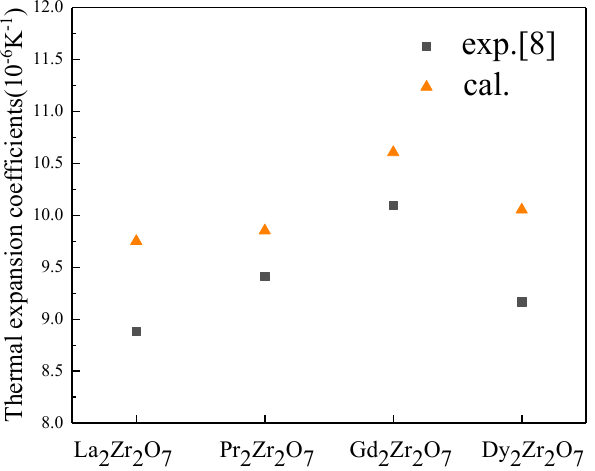
Figure 3. α ∞ and α of La 2 Zr 2 O 7 , Pr 2 Zr 2 O 7 , Gd 2 Zr 2 O 7 , and Dy 2 Zr 2 O 7 . 3.5. The Effect of Yb Doping of Gd 2 Zr 2 O 7 on α ∞ α ∞ of Gd 2 Zr 2 O 7 with 4 different Yb doping contents Gd 2 Zr 2 O 7 , (Gd 0.875 Yb 0.125 ) 2 Zr 2 O 7 , (Gd 0.875 Yb 0.3125 ) 2 Zr 2 O 7 , and (Gd 0.5 Yb 0.5 ) 2 Zr 2 O 7 were calculated. Table 4 shows the calculation result of theoretical density, sound velocity, and Debye temperature. Table 4. Density (ρ), longitudinal wave velocity ( υ L ), shear wave velocity of sound ( υ S ), average velocity of sound ( υ m ) and Debye temperature ( T D ) of rare earth zirconates.